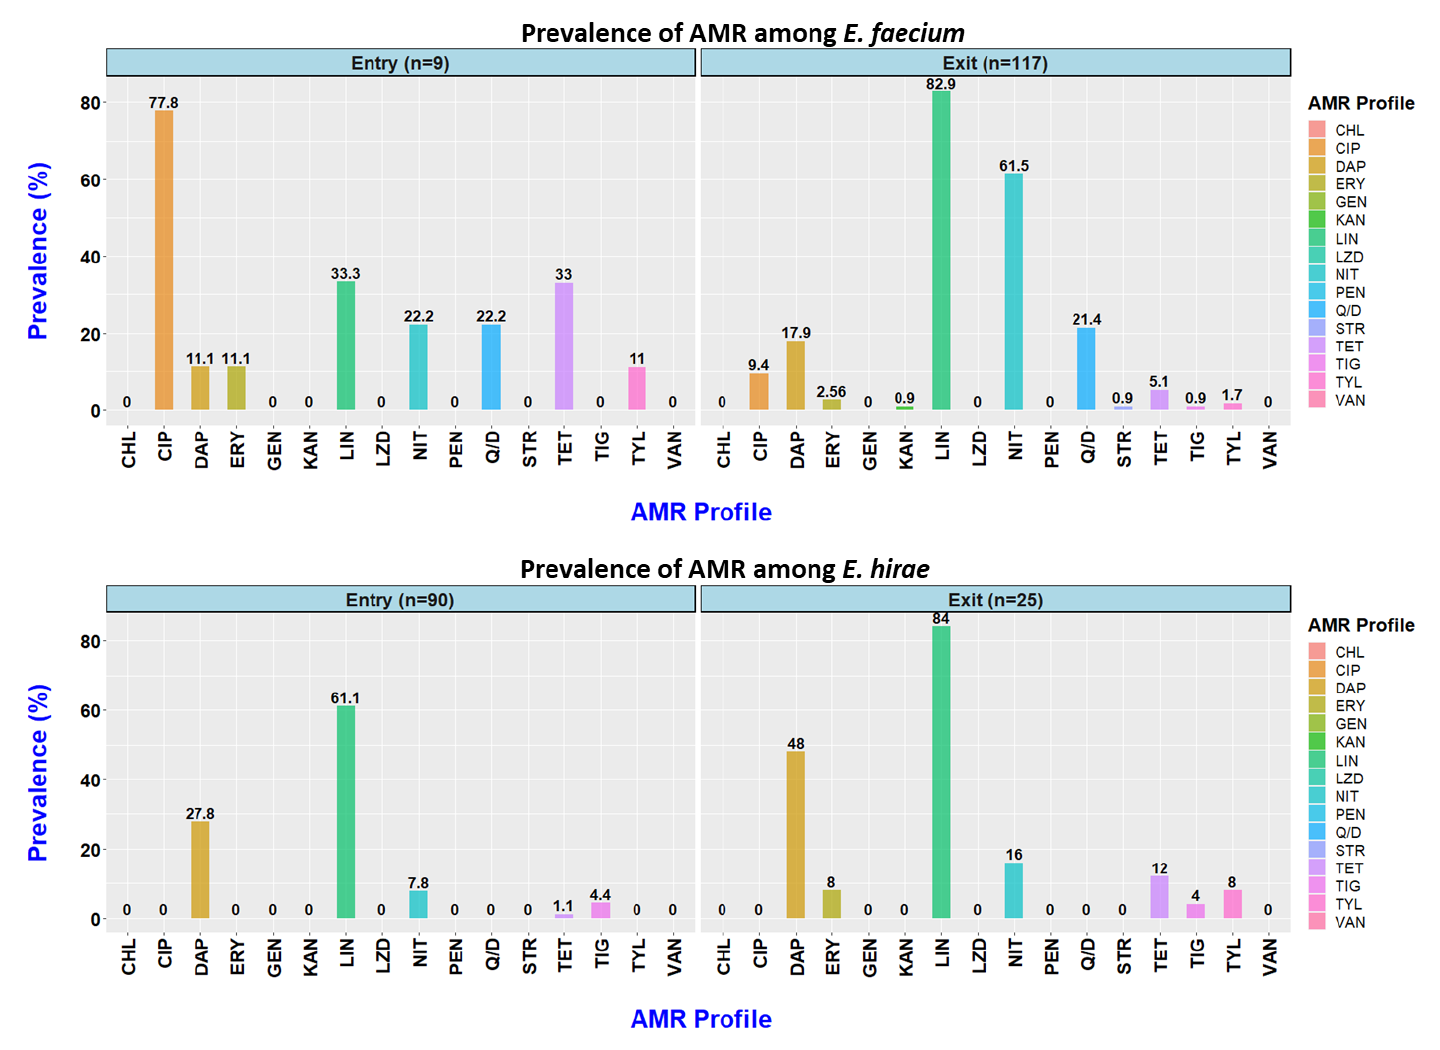
Figure 1. Prevalence of resistance to 16 antimicrobials observed among Enterococcus faecium and Enterococcus hirae isolated from faecal samples obtained at entry to (9 E. faecium ; 90 E. hirae ) and exit from (117 E. faecium ; 25 E. hirae ) an Australian feedlot.